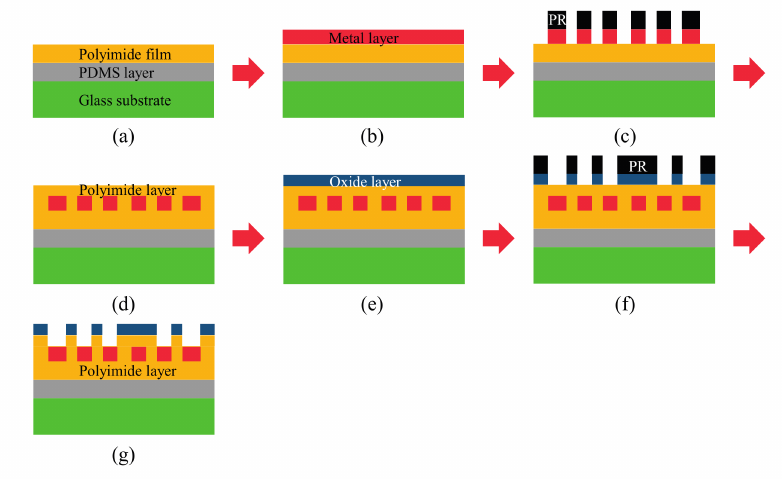
Figure 2. Schematic of the first part of the fabrication procedure: ( a ) deposition of the polydimethylsiloxane (PDMS)/polyimide (PI) film layers; ( b ) deposition of the metal layer (Ti/Cu) by E-beam evaporation; ( c ) patterning of the interconnect layer by the first photolithography; ( d ) deposition of the insulation layer by spin coating; ( e ) deposition of the SiO 2 layer by plasma-enhanced chemical vapor deposition (PECVD); ( f ) patterning of the SiO 2 layer by the second photolithography; ( g ) etching of the insulation layer to complete the fabrication of the sensor device platform.